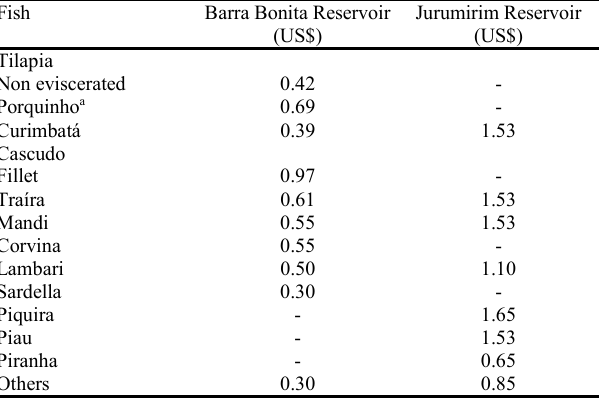
Table 5. Price of fish in the Barra Bonita and Jurumirim reservoirs. a “Porquinho” processing consists of removing the dorsal and anal fins, head, viscera, and sometimes the scales and